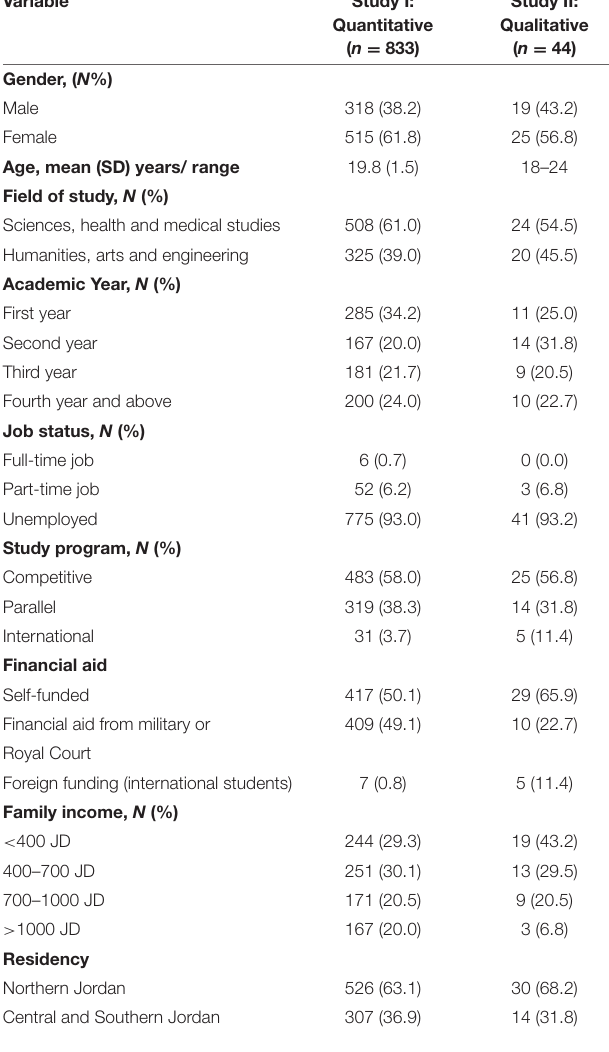
TABLE 3 | Demographic characteristics of